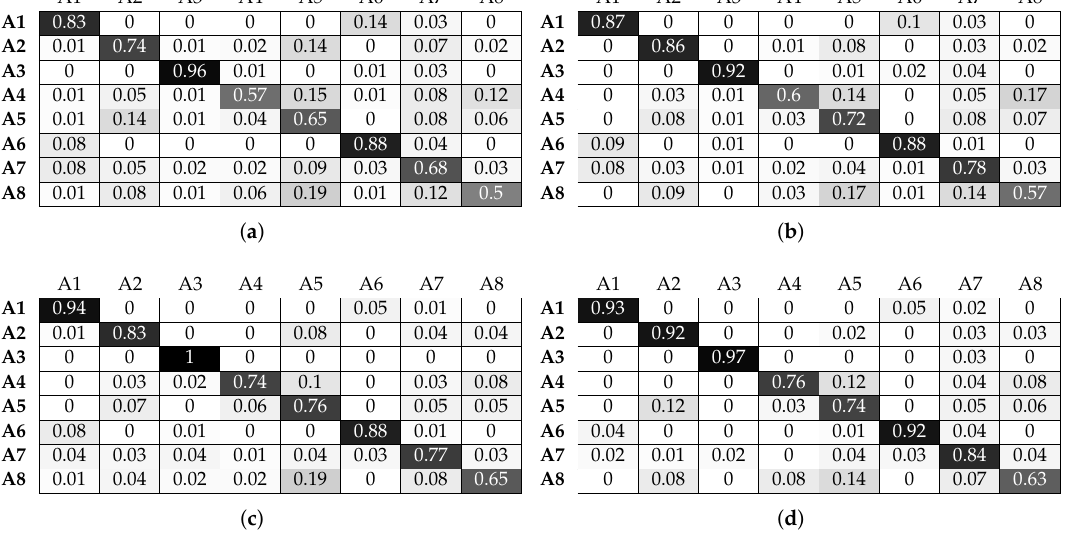
Figure 16. Normalised confusion matrices for SVM, with Wearable Feature Type 2, without beacon data. ( a ) C = 10, γ = 0.1, w = 1 s; ( b ) C = 10, γ = 0.1, w = 2 s; ( c ) C = 10, γ = 0.1, w = 3 s; ( d ) C = 10, γ = 0.1, w = 4 s. Sensors 2017 , 17 , x